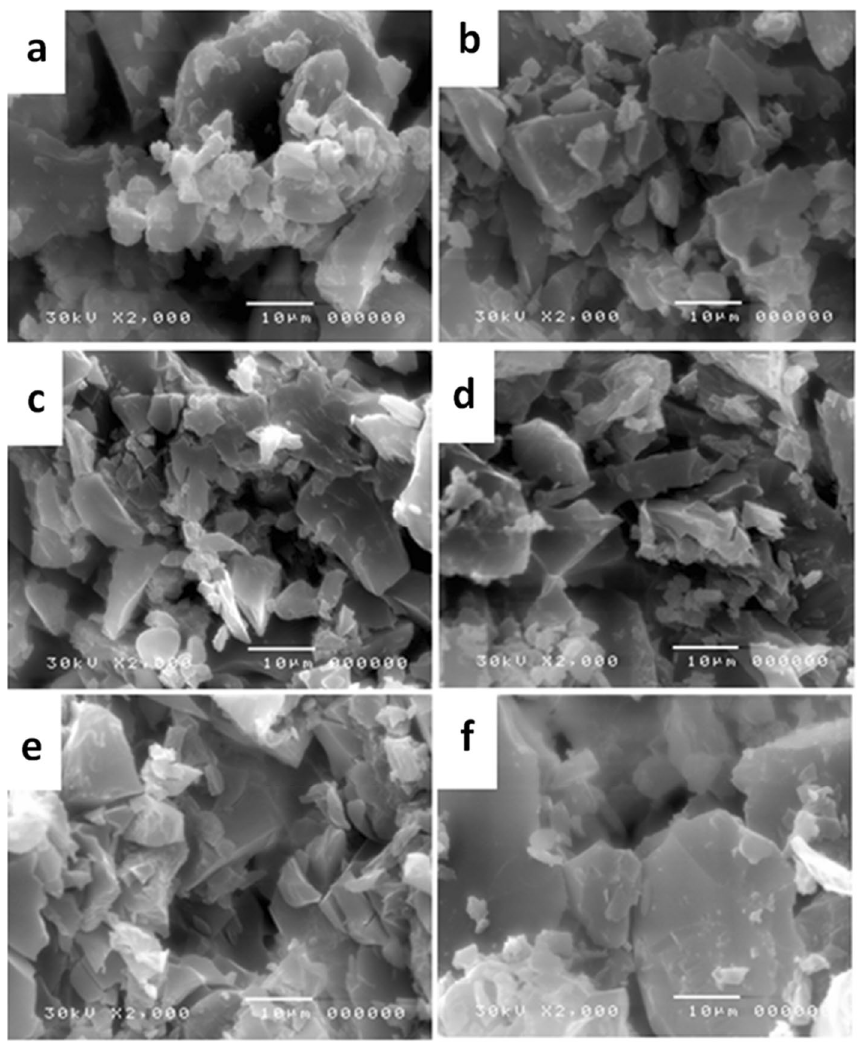
Figure 6. SEM photomicrographs of ( a ) R-0, ( b ) R-20, ( c ) R-40, ( d ) R-60, ( e ) R-80 and ( f ) R-100 samples with fixed rate of dose ~ 0.9